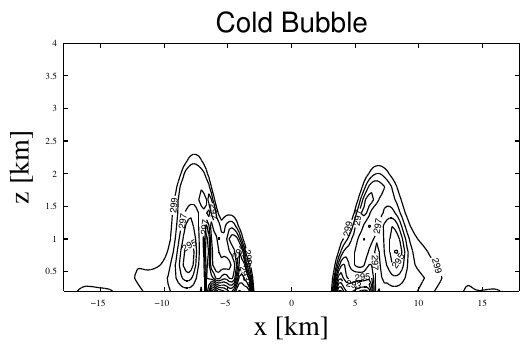
Fig. 3. Result for the cold bubble test case after 900 s (contours: pot. temp.